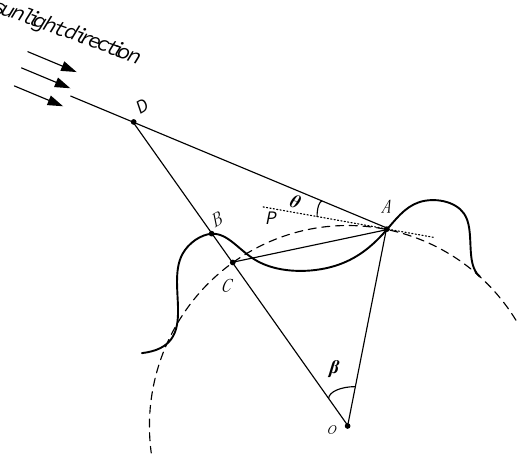
Figure 2. Schematic of illumination condition.